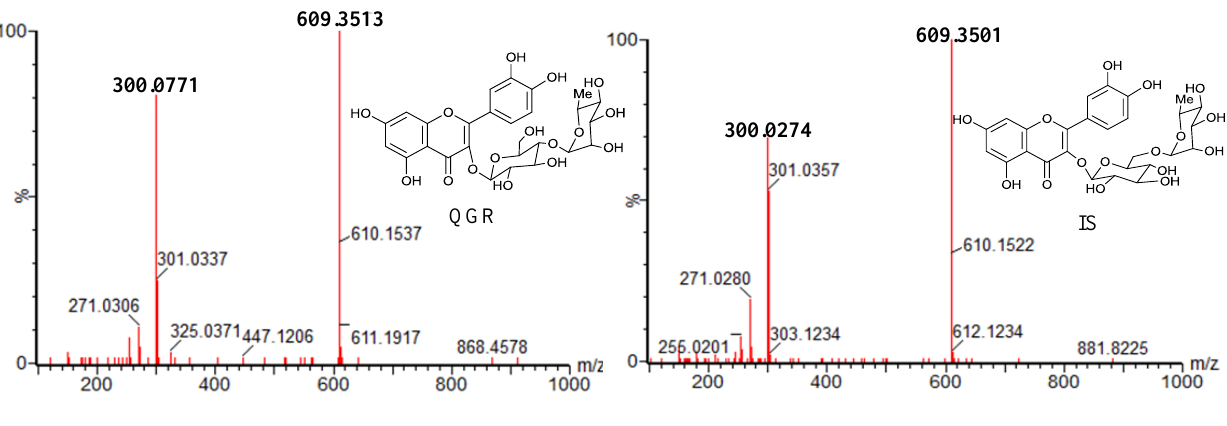
H O , MW = 27 30 16